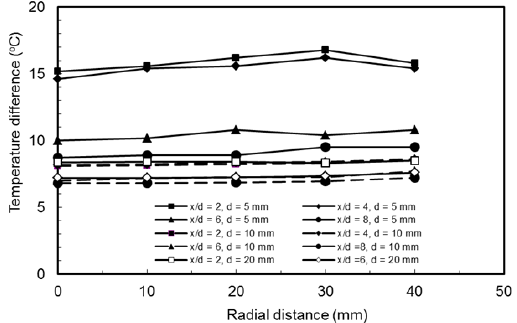
and analogous to the velocity distributions. The present data are supported by the findings of Tu and Wood [17] and Guo and Wood [18].